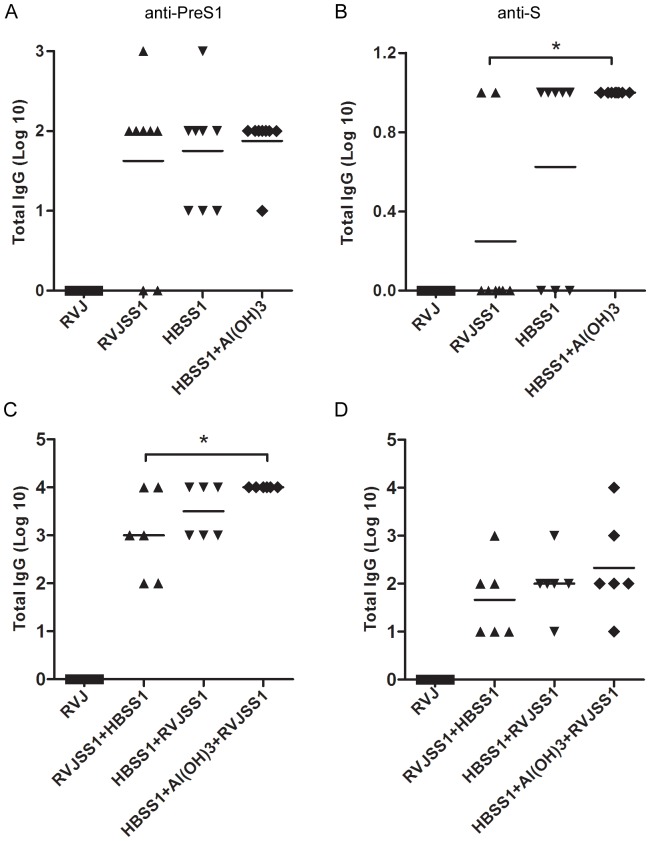
The anti-PreS1 and S antibody responses elicited by different regimens detected after first immunization (A–B) or second immunization(C–D).Each group received a different prime–boost vaccination, and antiserum was collected 2 weeks after the each immunization. Total HBV antigen-specific IgG titres were determined by ELISA. The symbols represent the titers of the sera from the individual mice. The horizontal lines represent the means (n = 6). The statistic significance of the results was analyzed and indicated as *p<0.05.